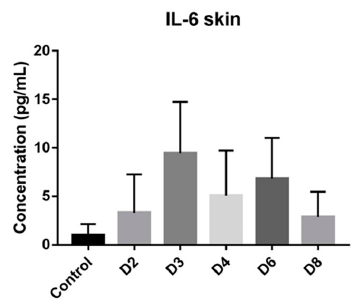
Figure 8. Cytokines concentration in both skin and serum samples. Data are presented as mean ± SD and statistically analyzed using one-way ANOVA followed by Tukey’s multiple comparison test. Only TNF- α level in serum at day 2 is significantly different from control. *: p < 0.05 ( n = 3, except for control where n = 4).